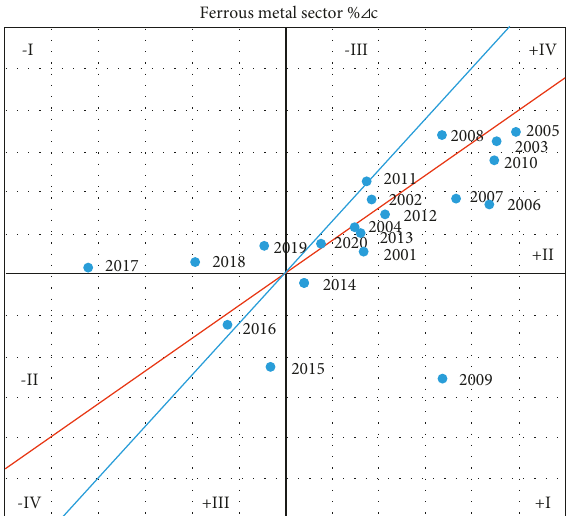
Figure 14: Carbon emission decoupling states of energy con- sumption in the ferrous metal sector from 2001 to